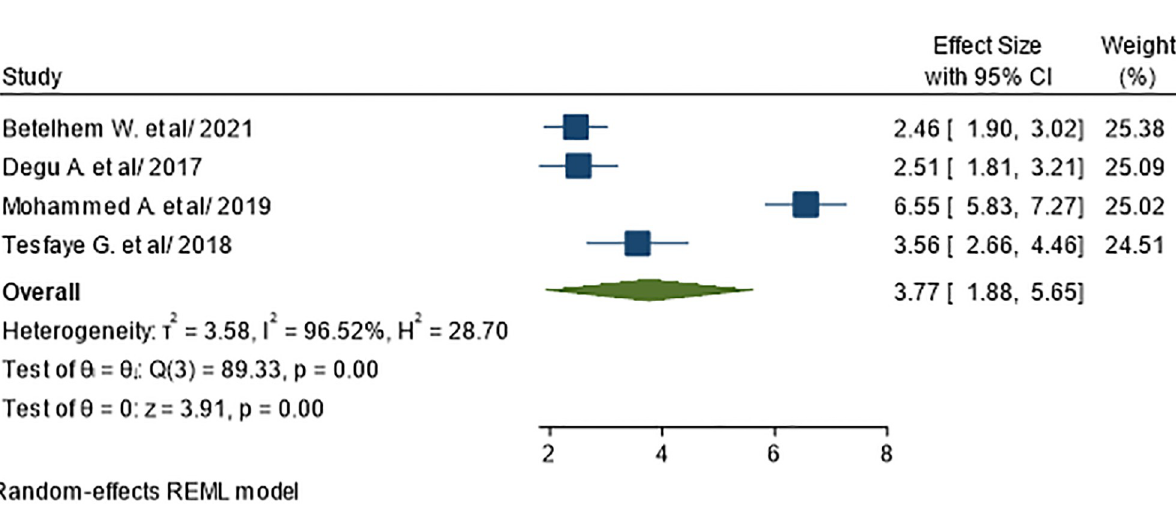
PLOS ONE | https://doi.org/10.1371/journal.pone.0278028 January 17,